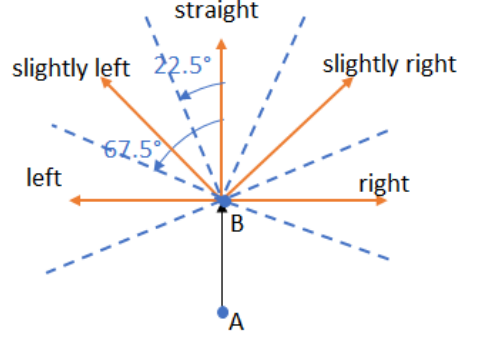
Figure 6. The qualitative system of directions